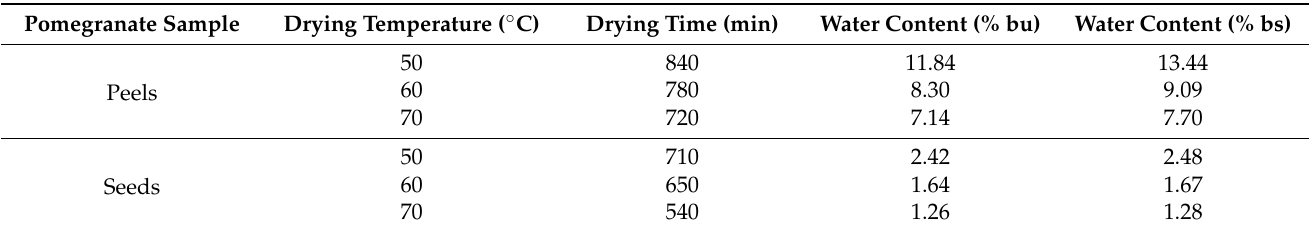
Table 2. Average values of drying times and water contents of pomegranate peel and seed flour at drying temperatures of 50, 60, and 70 ◦